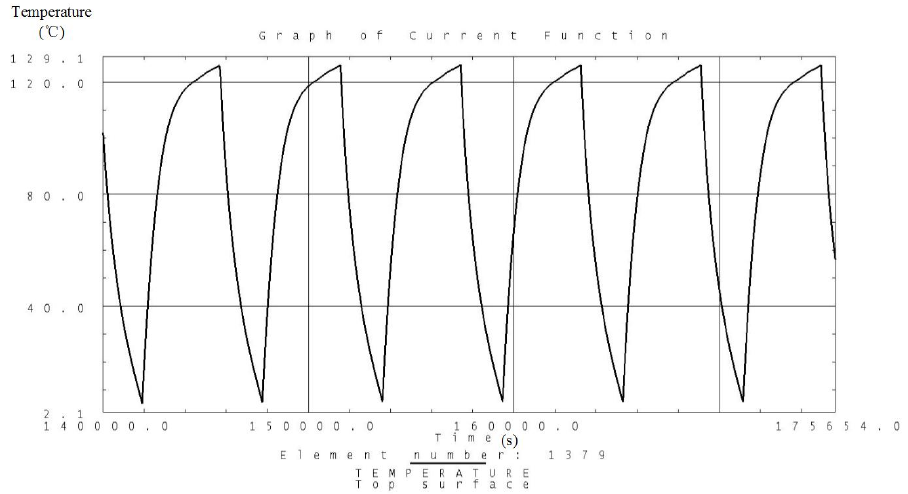
Figure 11. Analysis result of the temperature variation curve of the solar panels under high temperature conditions.